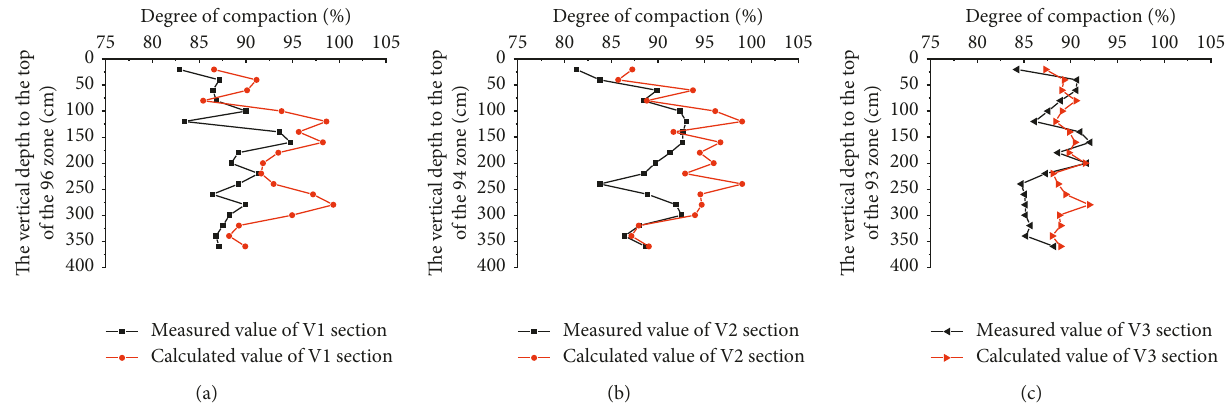
Figure 10: Degrees of compaction calculated according to different water contents. Comparison of section: (a) V1; (b) V2; (c)